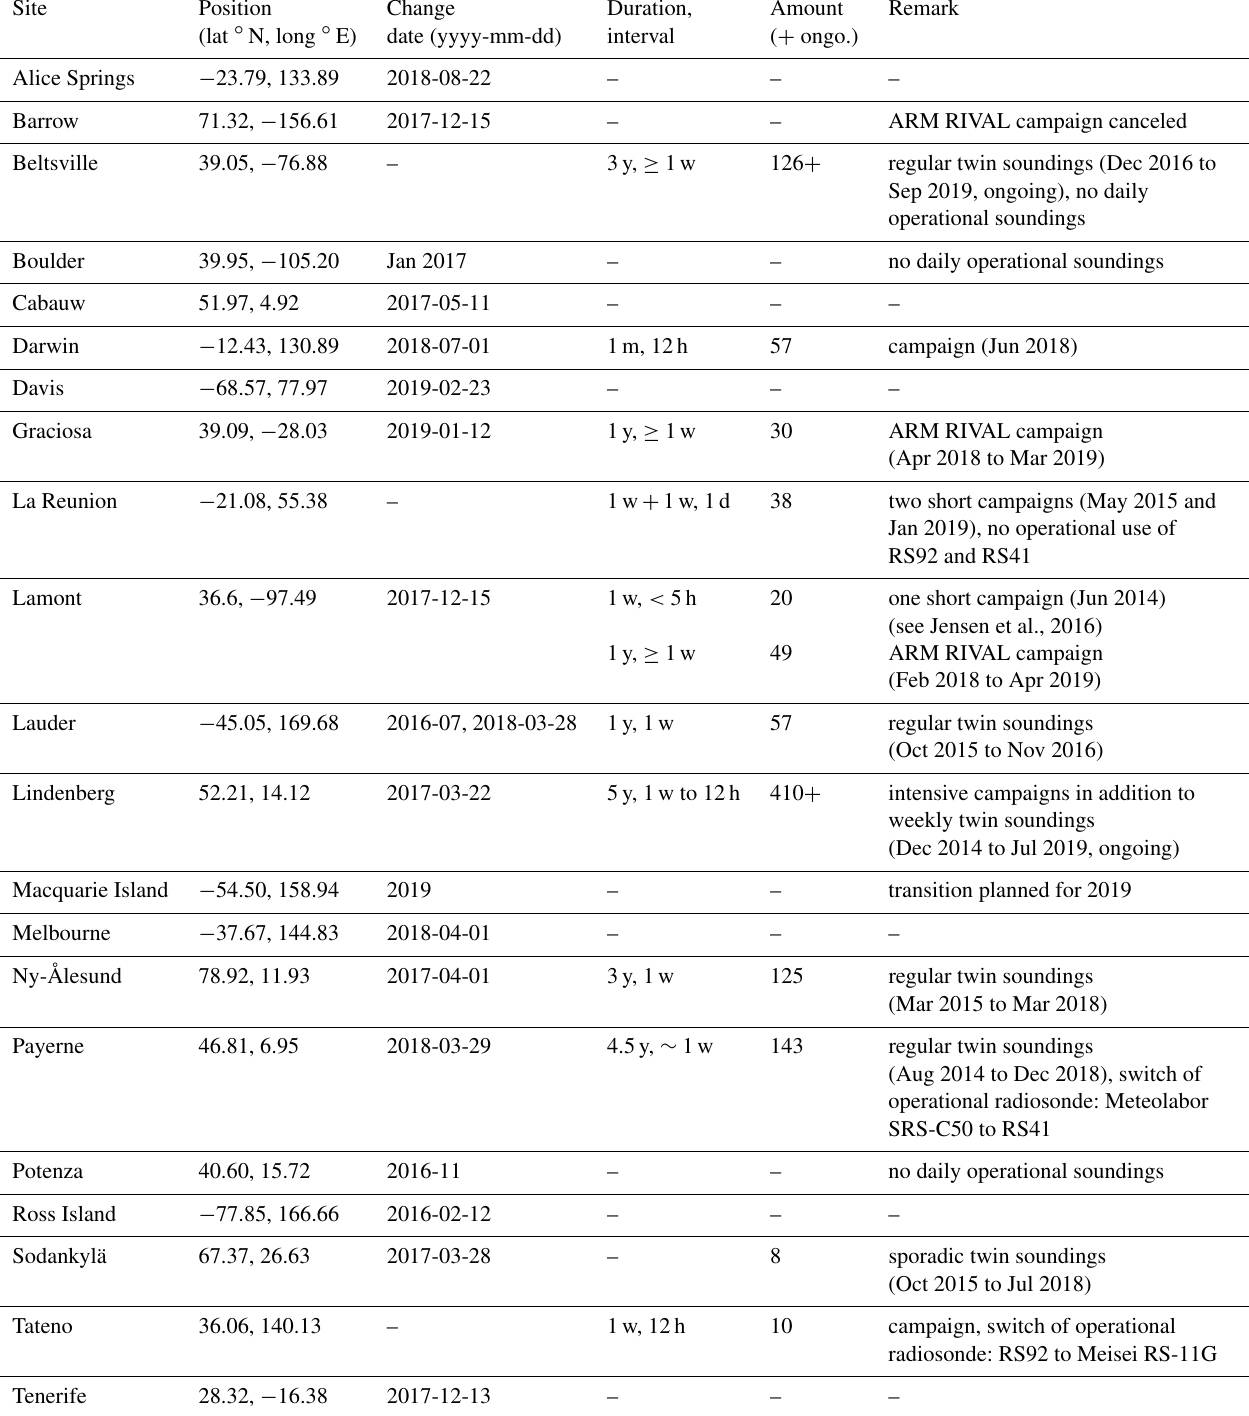
Table 1. List of GRUAN sites that are involved in the RS92–RS41 transition. Listed are the dates on which a site switched from RS92 to RS41 as the operational radiosonde for the sites, the length and frequency of the twin sounding programs, and the number of twin soundings performed (y – year, m – month, w – week, d – day, h –